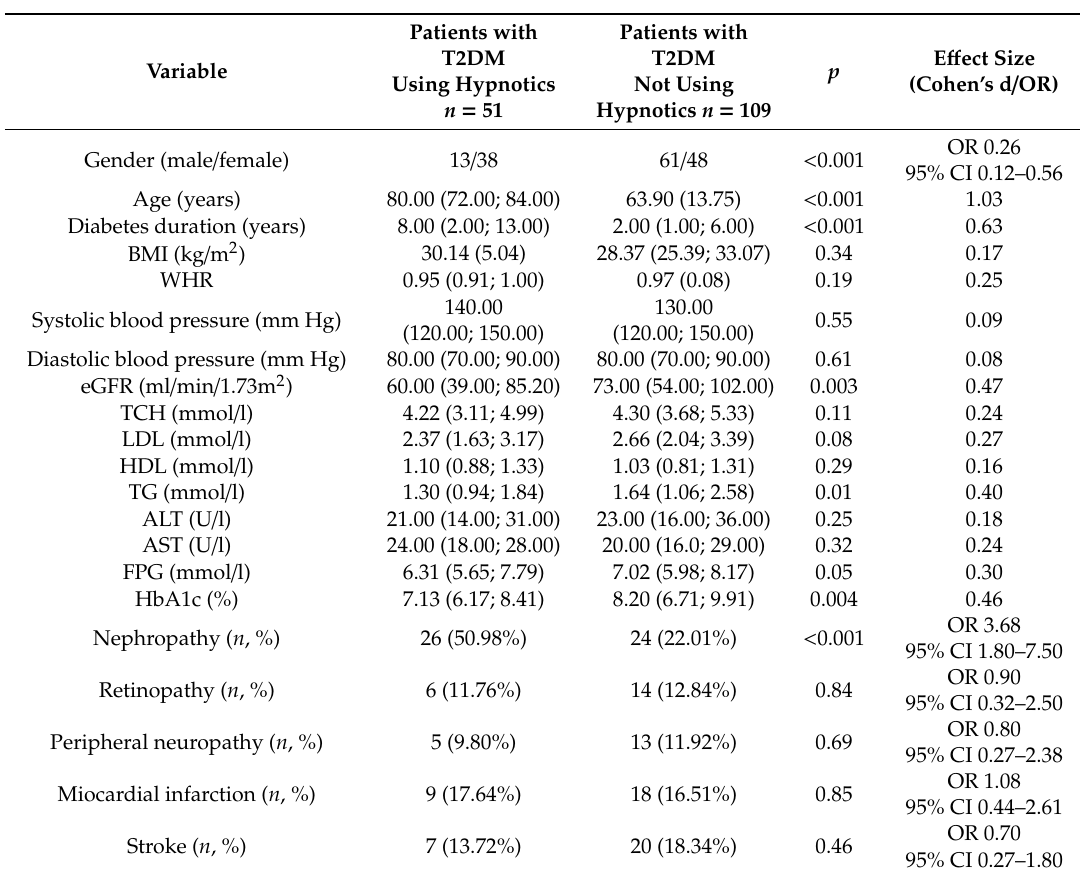
Table 4. Phenotype of users and non-users of hypnotics among T2DM